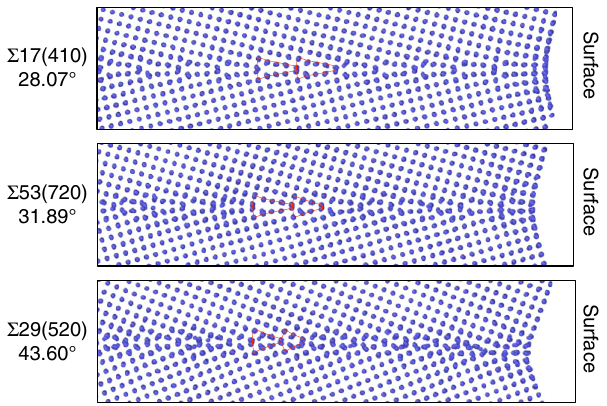
Fig. 6 Equilibrium structures at high temperature. High-temperature Split- Kite grain boundary phases of three representative grain boundaries independently predicted by molecular dynamic simulations. Grain boundary phase transitions occur in the simulations, because open surfaces and grain boundary diffusion at 900 K enable variation of the atomic density in the GB core. The structures match the predictions of the evolutionary search at 0